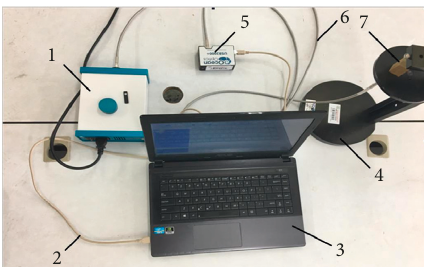
Figure 2: Spectraldataacquisitionsystem’sstructuregraph:(1)halogen lamp;(2)universalserialbus;(3)computer;(4)holder;(5)spectrometer; (6) optic fiber; (7) test